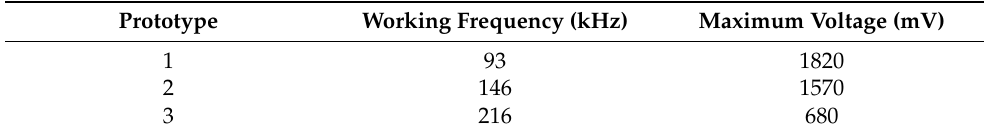
Figure 7. Behavior for prototype 1 in several types of soils.